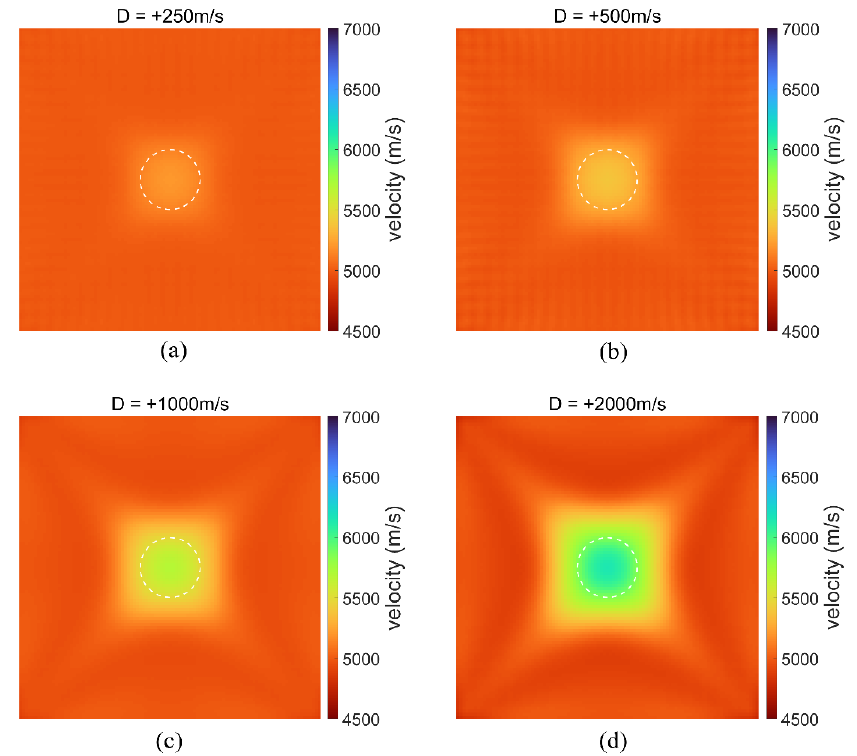
Figure 7. Tomographic results obtained by TDAT with different high-velocity anomalies. D: velocity difference between background and anomalous area.